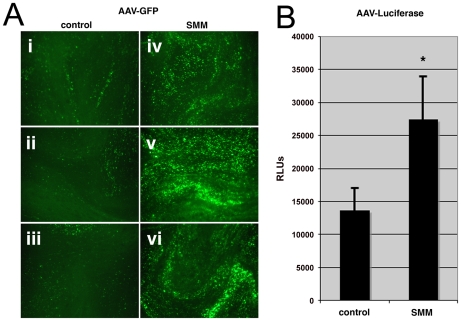
Human airway epithelium under stress is more susceptible to AAV infection.HAE cultures were exposed to SMM an inflammatory stimulant derived from CF airways by application to the apical surface to induce cellular stress and model diseased airway. 24 hr after application, SMM was removed and HAE infected with an AAV variant generated by molecular directed evolution. A. Representative en face images of three HAE cultures one week after inoculation with AAV packaging an eGFP transgene, showing GFP positive cells (green) in HAE cultures exposed to PBS (panels i, ii, and iii) or SMM (iv, v, and vi). B. Parallel experiments performed on HAE cultures with an AAV packaging a Luc transgene. Cells were harvested one week after inoculation and luciferase activity was assessed. Error bars represent standard deviations from three separate inoculations. Data shown are representative from three independent experiments (* p-value<0.05).